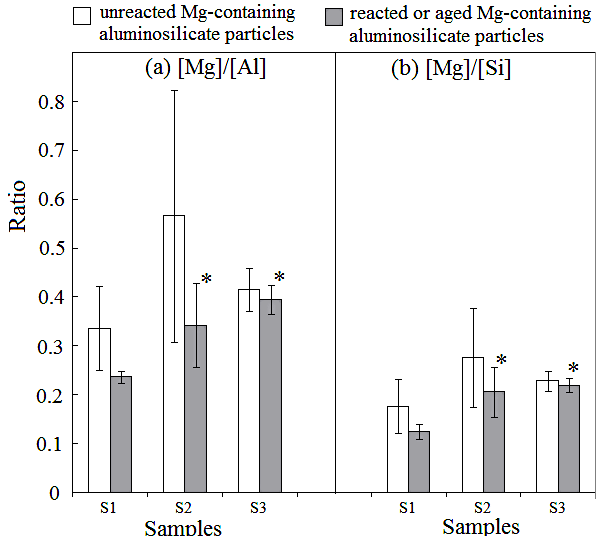
Fig. 9. Atomic concentration ratios of [Mg]/[Al] and [Mg]/[Si] for unreacted and reacted aluminosilicate particles in samples S1– S3 (Note: for the unreacted aluminosilicate particles, 182 Mg- containing species were considered; and for the reacted or aged ones, 1152 Mg-containing species were considered. Statistical com- parisons of [Mg]/[Al] or [Mg]/[Si] ratios between samples S1 and